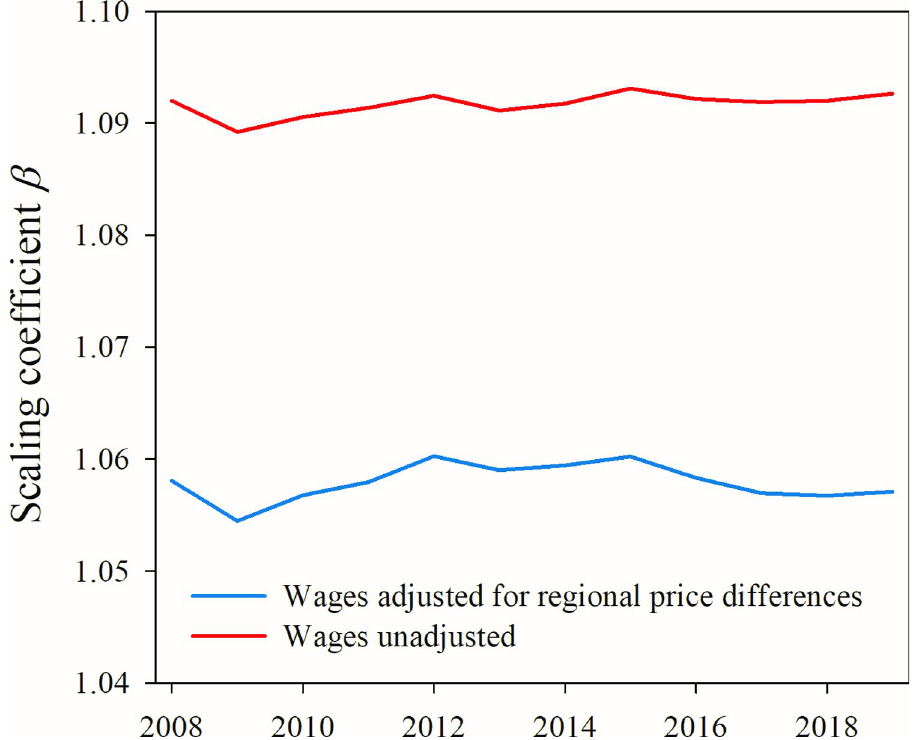
Fig 3. Cost of living effect on the metropolitan urban wage premium. When adjusted for local cost of living, scaling coefficients of log(wages) vs. log(employment) is suppressed by an average of 0.034 in all years compared. Cost of living factors, taken from [20], were published only for metropolitan statistical areas and only for years 2008–2019 at the time of our study.